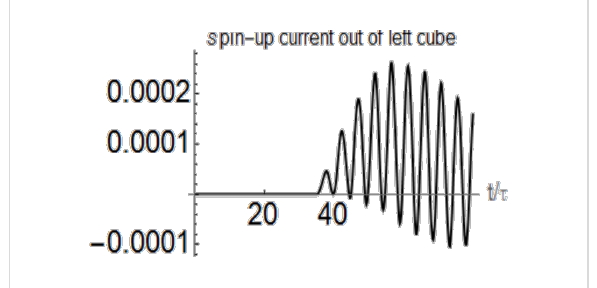
Figure 5: Spin-up current from the left storage cube in the cube–cube connection, when both storage cubes have eight sites. The hopping integral in the cube–cube wire is t ext = 0.05 t h . The spin-down current is opposite.